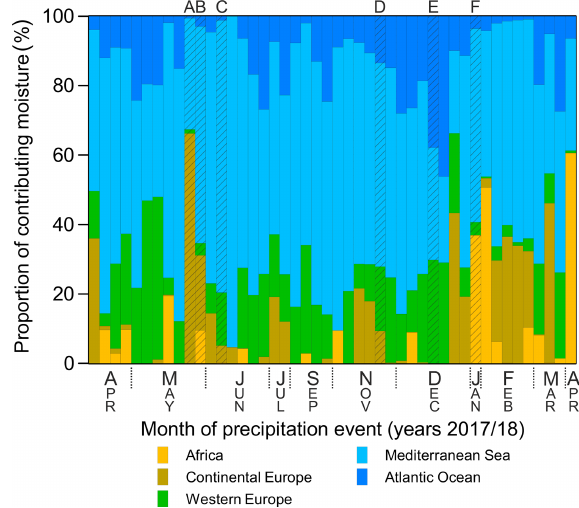
Figure 3. Relative moisture contribution of each tritium source re- gion to individual precipitation events (depicted as vertical bars) based on 10d trajectories. Events are listed in chronological order, with their month on the x axis. The letters on top of the graph cor- respond to outlier events as detailed in Fig. 7 and in the